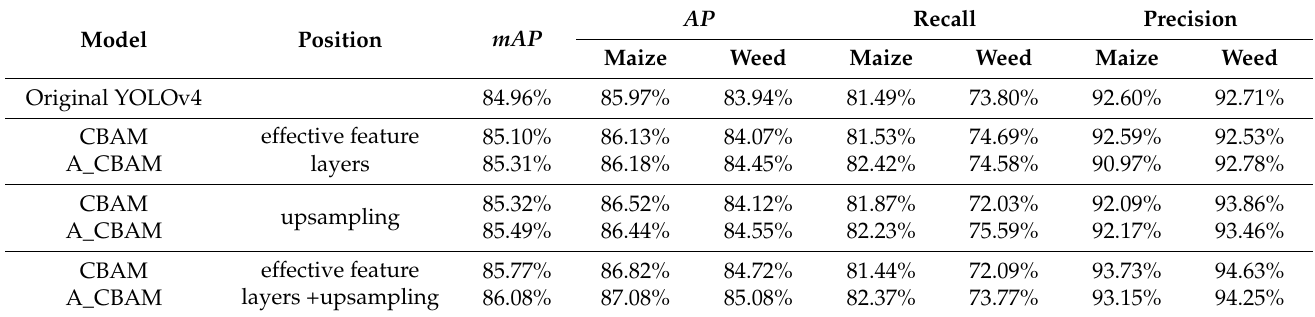
Table 4. Attention module ablation experiment.